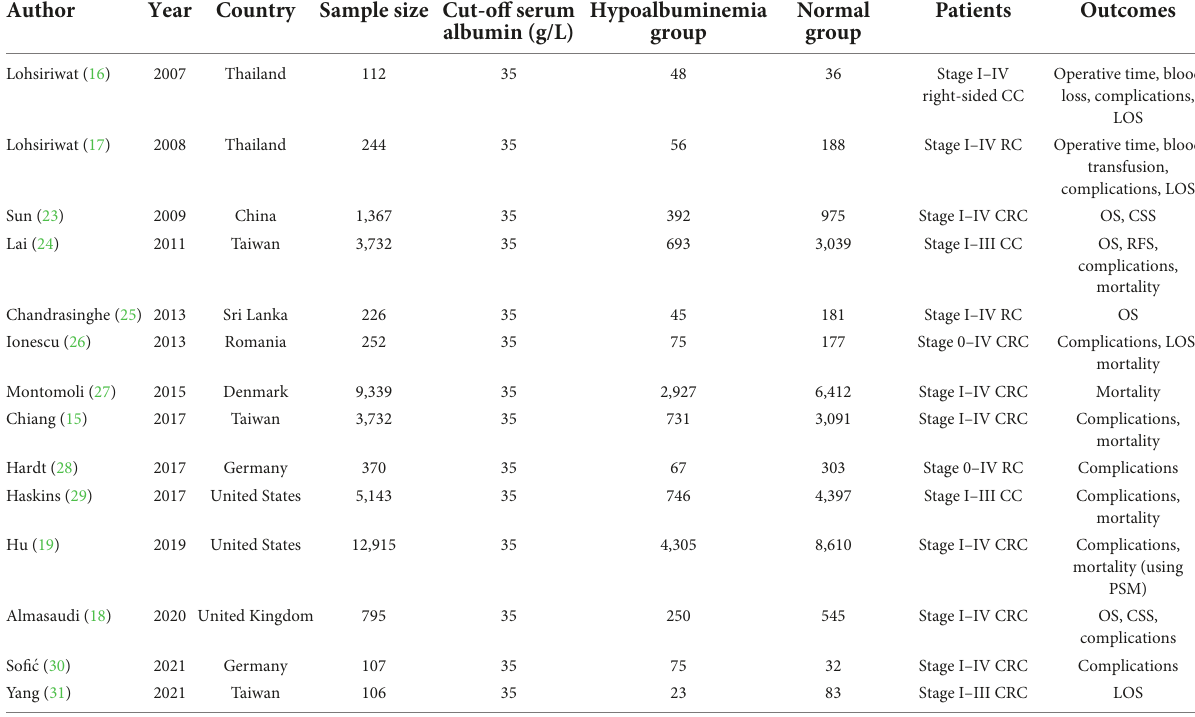
TABLE 5 Previous studies reporting the Hypoalbuminemia on the outcomes of CRC